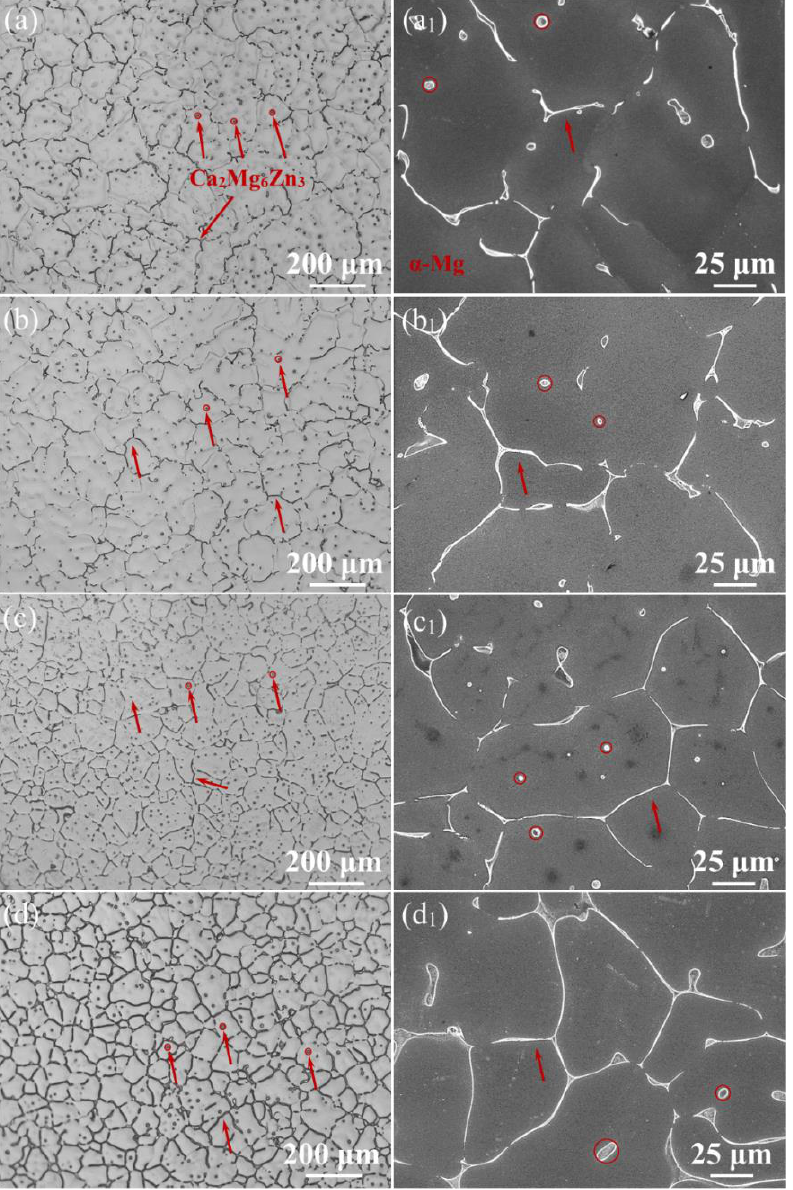
Figure 1. OM ( a – d ) and SEM ( a 1 – d 1 ) micrographs of the as-cast ZM-0.1Ca ( a , a 1 ), ZM-0.3Ca ( b , b 1 ), ZM-0.5Ca ( c , c 1 ) and ZM-1.0Ca ( d , d 1 ) alloys.